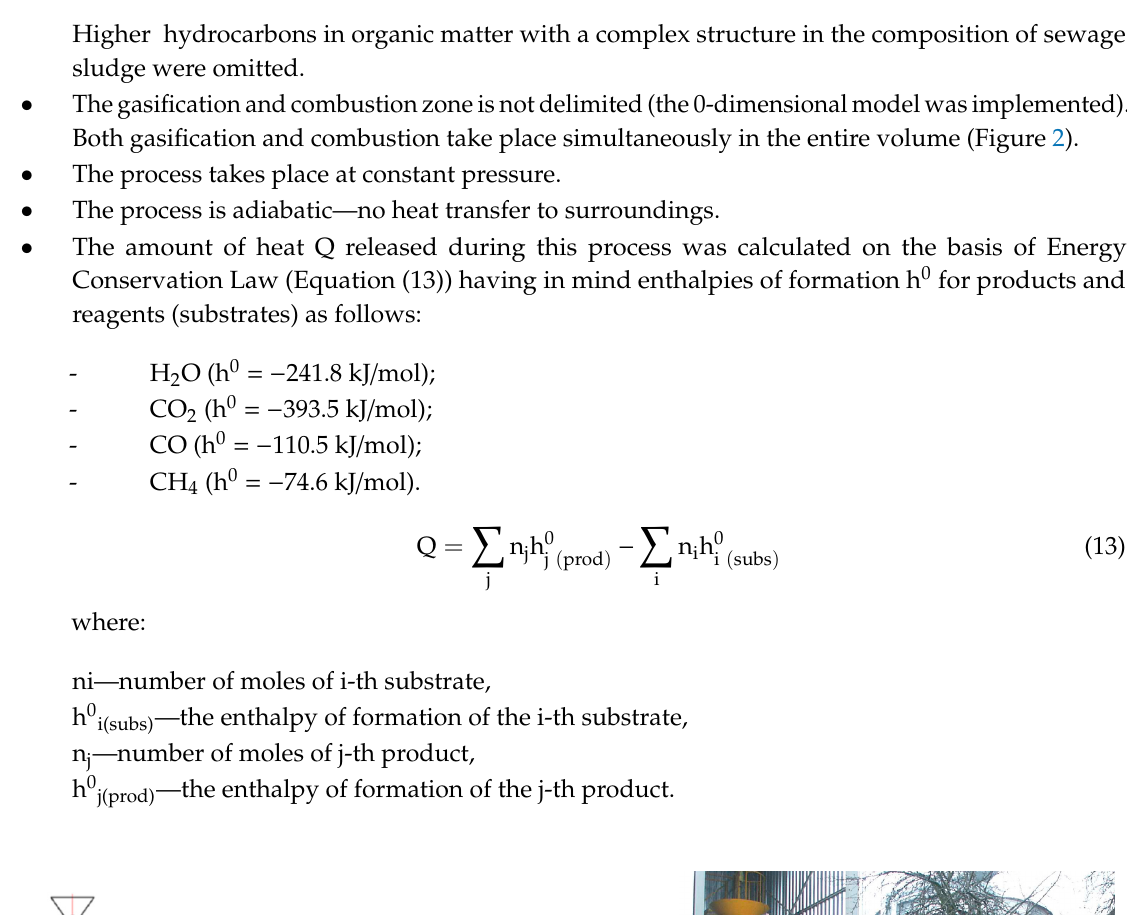
Table 2. Gasification system specifications.